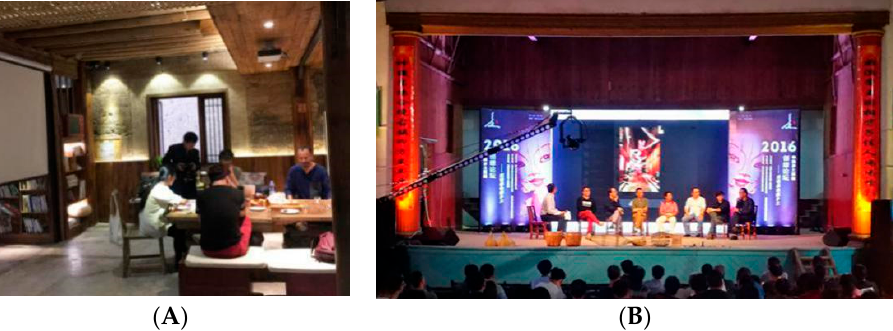
Figure 5. ( A ) Demonstration of operating the Relax Inn. ( B ) An experience exchange